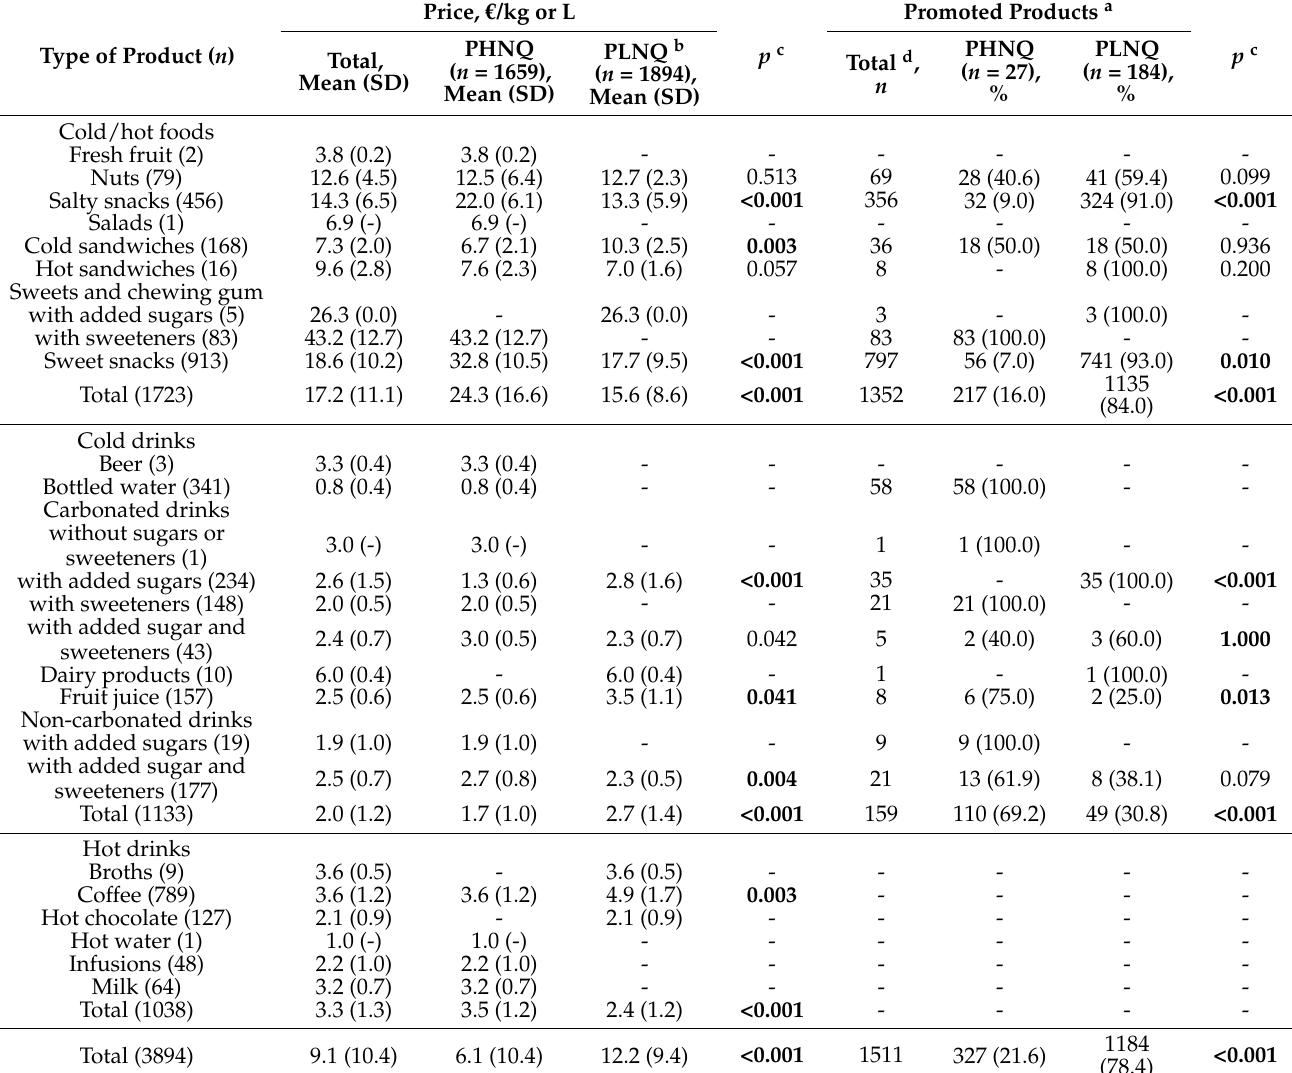
Table 5. Relationships between nutritional profile and the promotion and price of products offered in vending machines at the University of the Basque Country